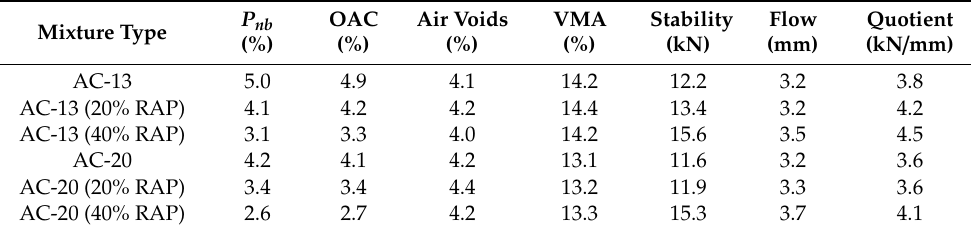
Table 6. Marshall mix design results.